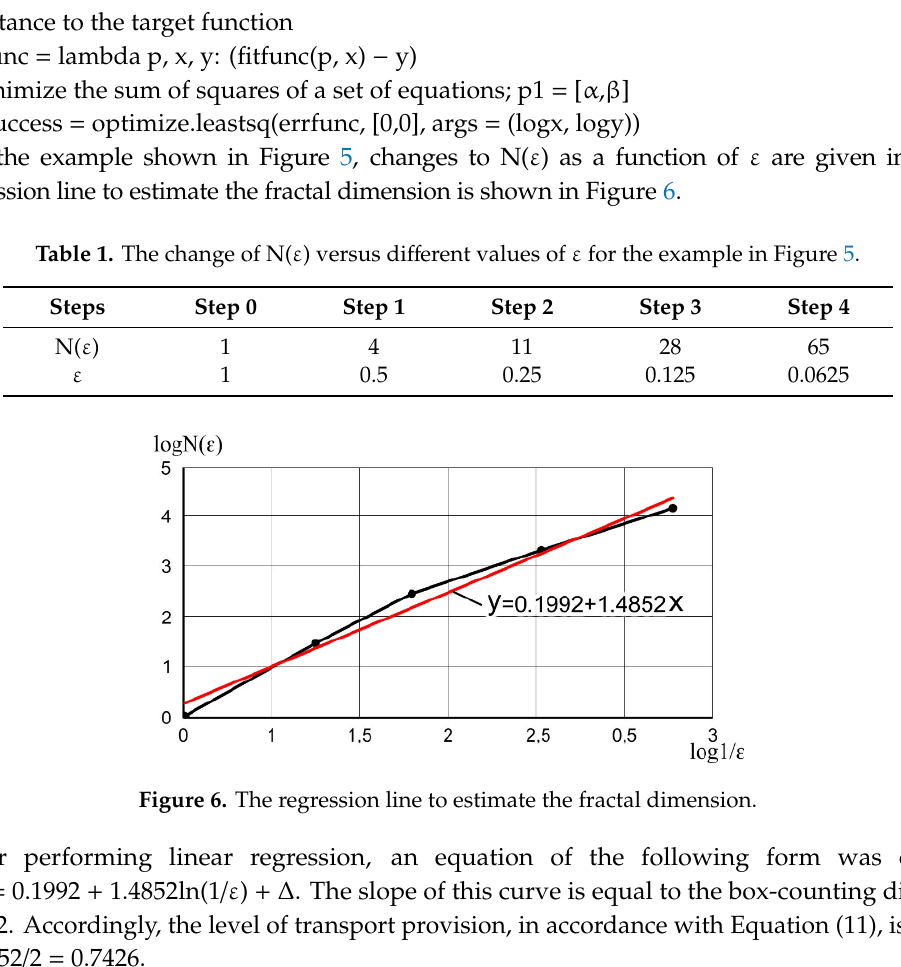
Figure 7. Fractal dimensions and transport utilization rates for different road patterns.